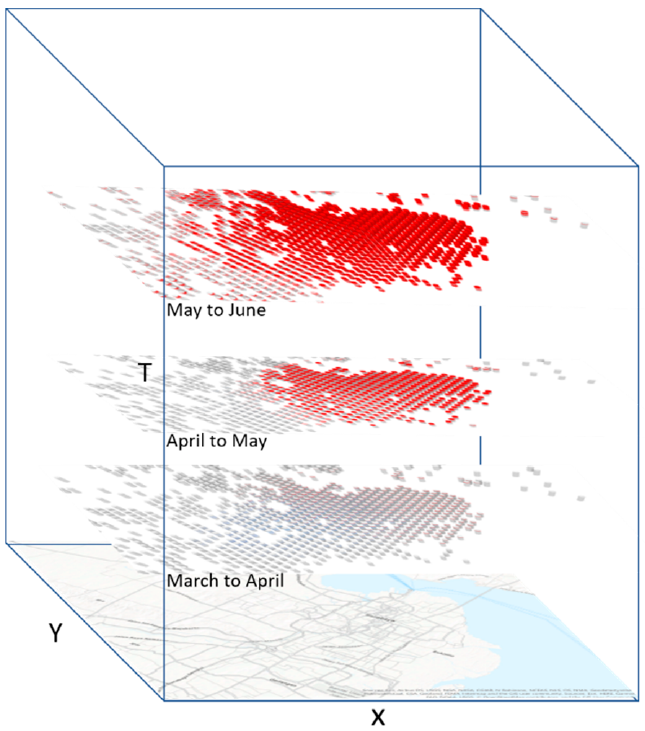
Figure 4. The STC design in a three-dimensional cube with x, y (spatial), and t (time).